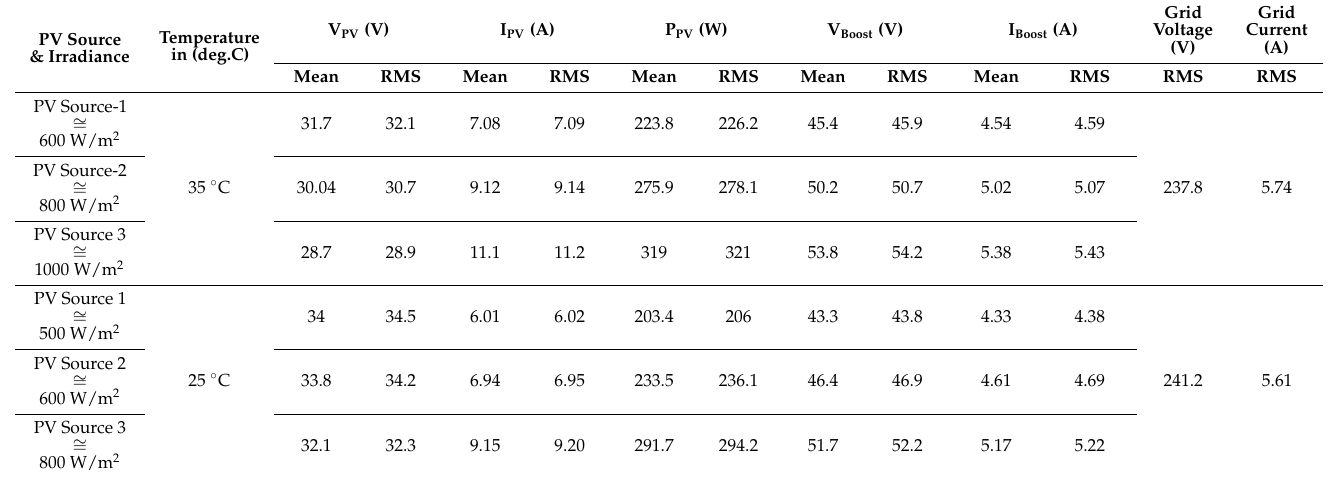
Table 9. Impact of solar irradiance and temperature on grid connected PV